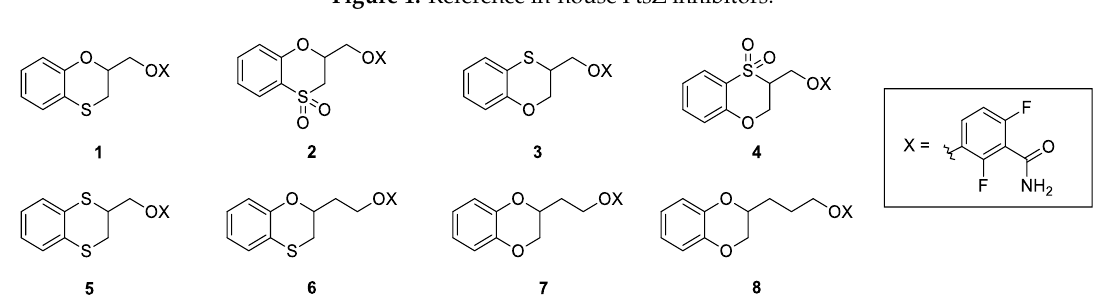
Figure 1. Reference in-house FtsZ inhibitors.